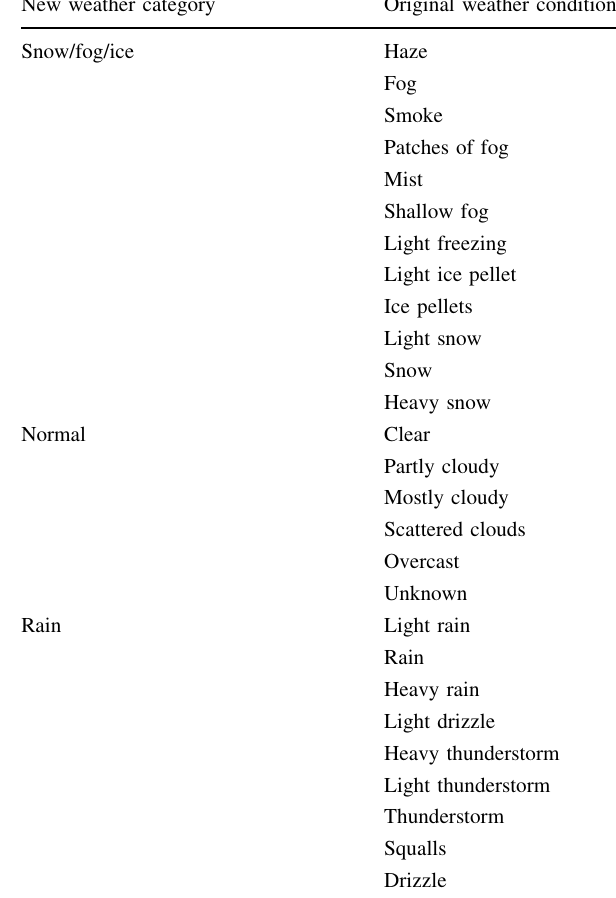
Table 5 Classification of the weather